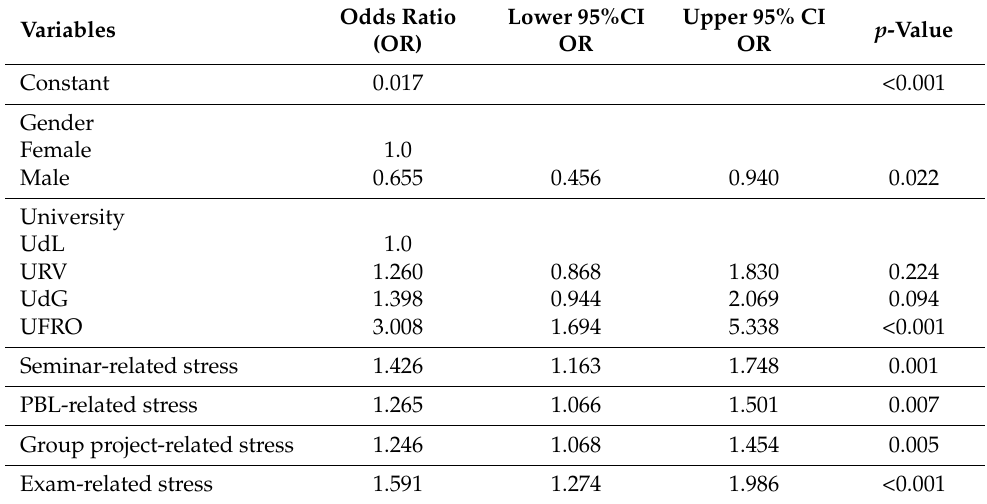
Table 4. Logistic regression model to evaluate the effects of sociodemographic and academic char- acteristics, together with the stress caused by different types of training activities on having a total GHQ-28 score higher than